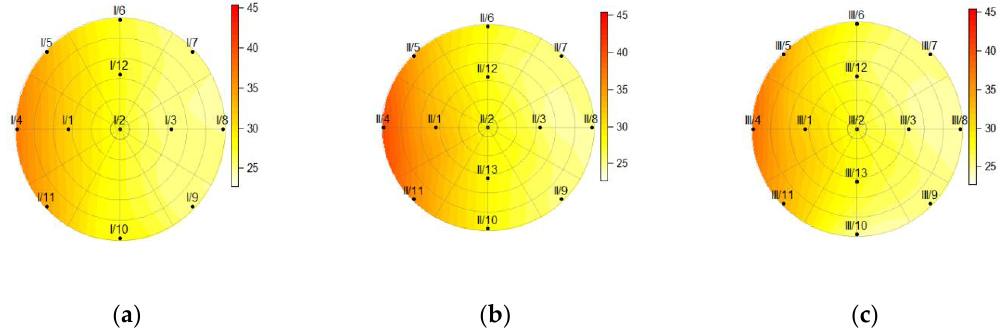
Figure 11. The temperature within the pillar at a height of ( a ) 150 mm; ( b ) 750 mm; ( c ) and 1350 mm, 2.5 h after the heat source was turned on.